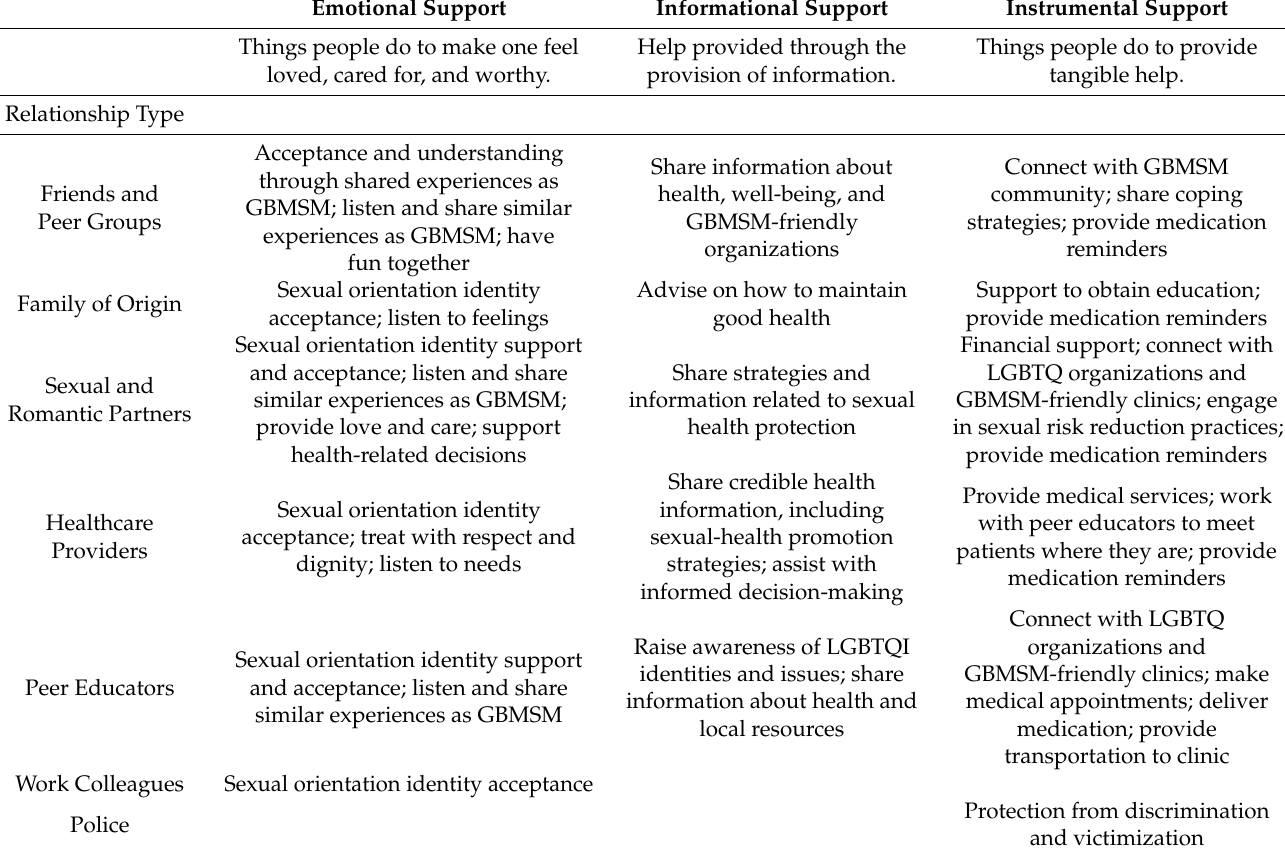
Table 2. Summary of types of social support provided by interpersonal relationship